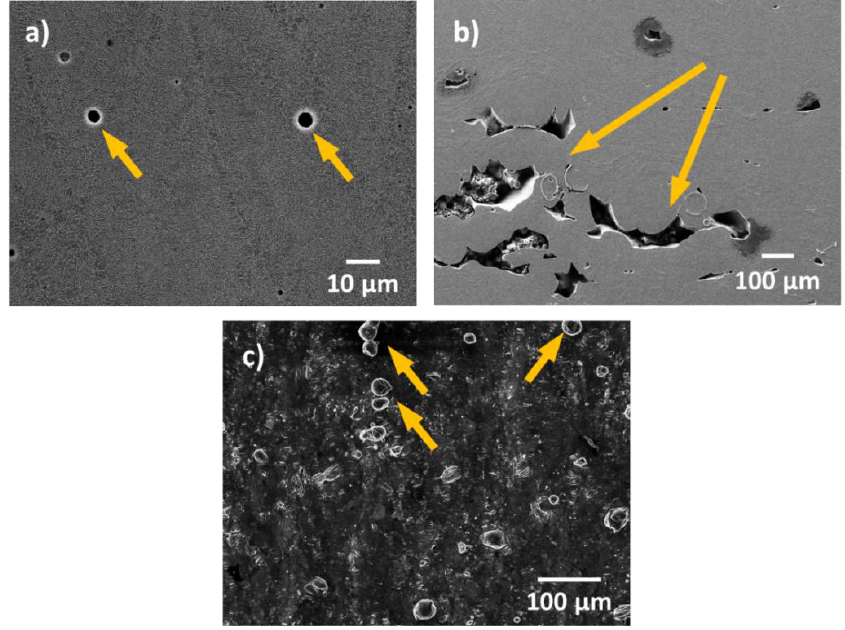
Figure 1. Secondary electron image representing defects that can be present in additively manufactured metal parts: ( a ) trapped-gas pores; ( b ) lack-of-fusion pores; ( c ) unmolten powder.